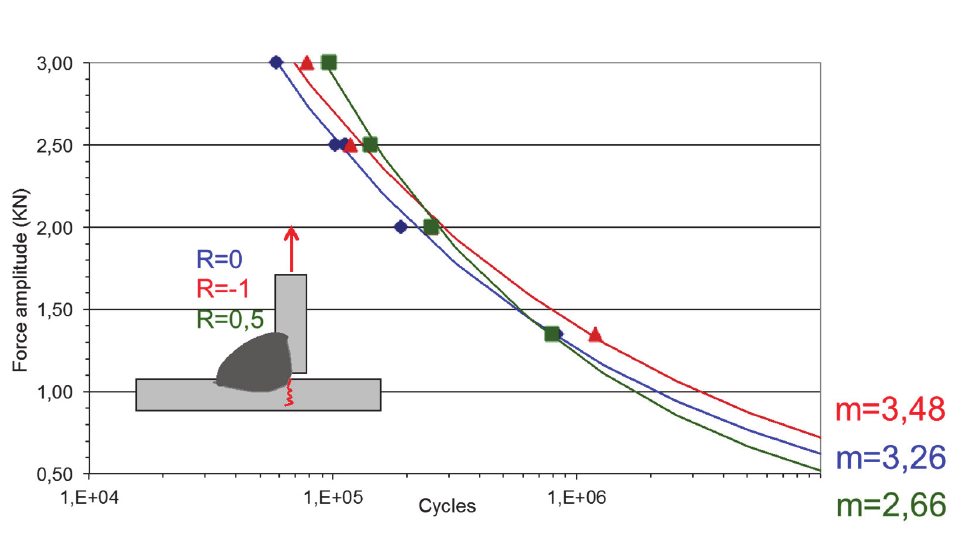
Figure 3: Fatigue life under tension for different load ratio.